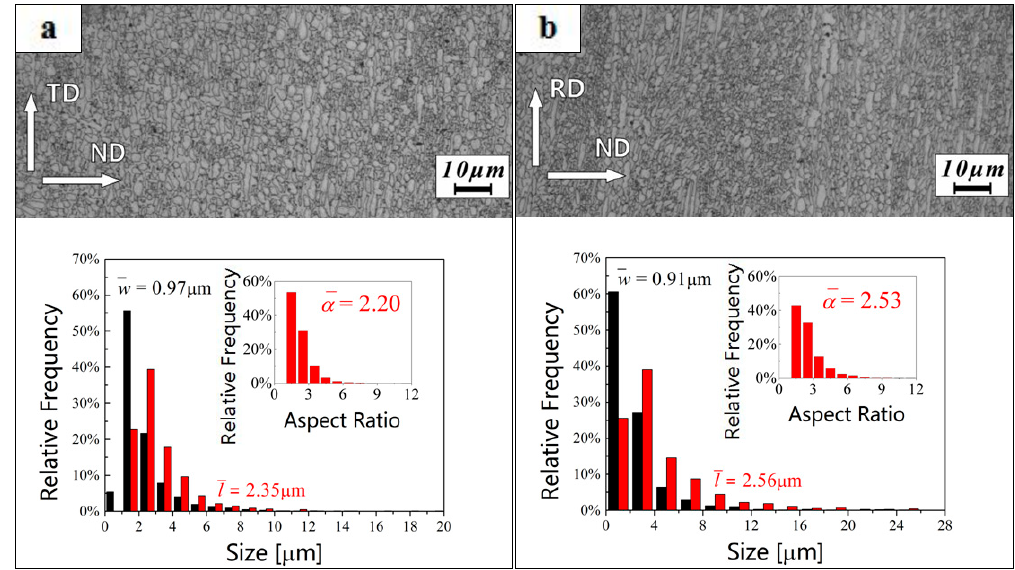
Figure 4. Statistics of the grain size distribution in the lamellar α phase and the microstructure of annealed β 20C observed from the ( a ) RD and ( b ) TD.